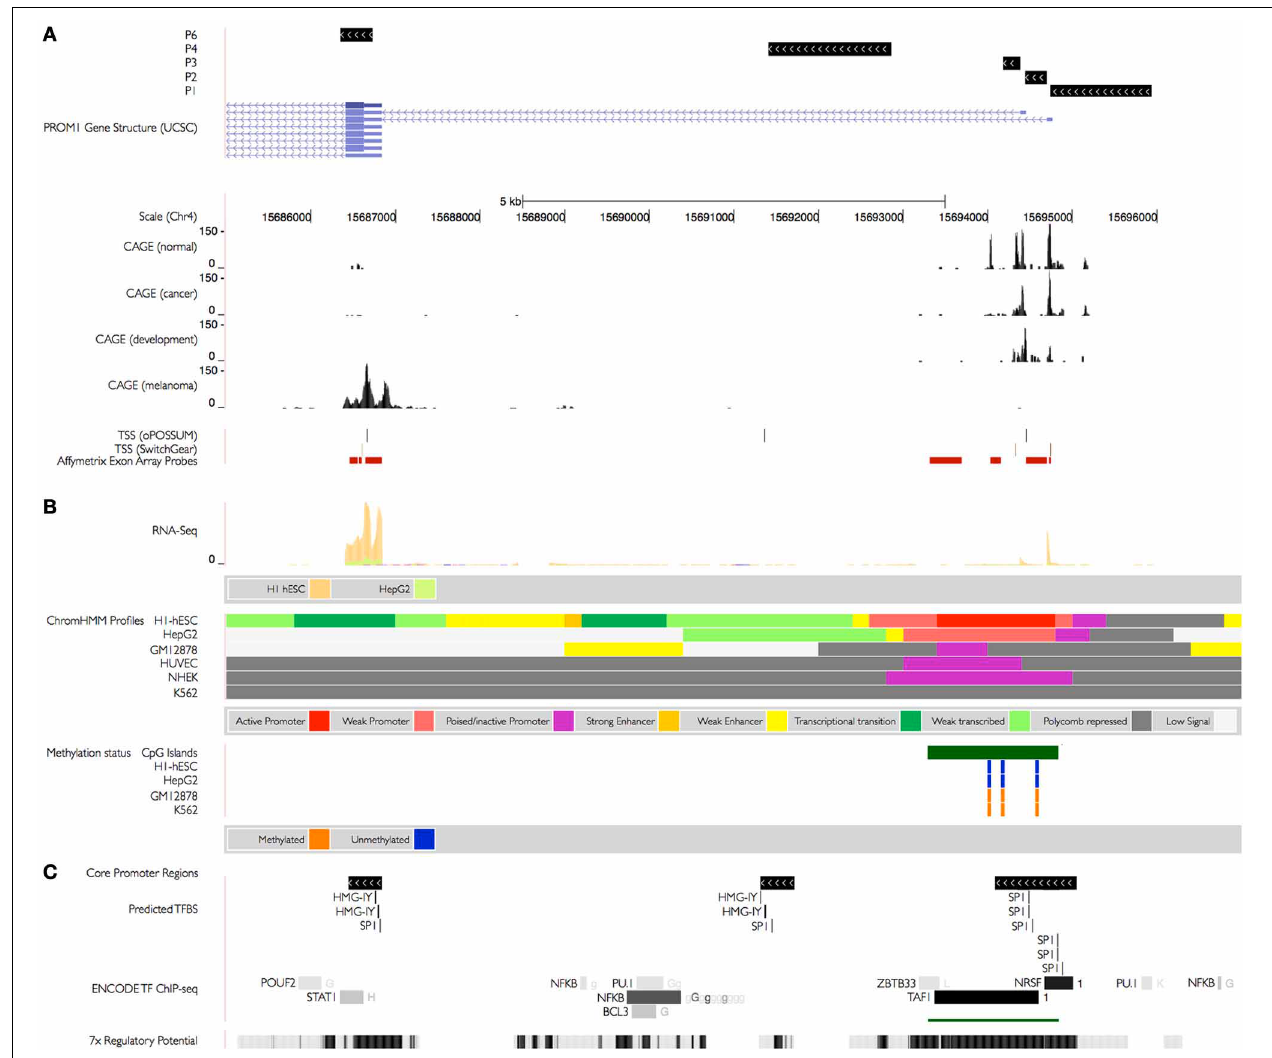
FIGURE 2 | PROM1 regulatory landscape. (A) Previously described PROM1 TSS (Promoter 1–3, 4) supported by Capped Analysis of Gene Expression (CAGE) assays from the FANTOM3 collection 57 containing 72 experimental samples of which 13 from normal tissues, 25 from different cancers, and 34 are from developmental states ( Table S3 ). Non-pathogenic tissue CAGE tags are distributed evenly whereas those obtained from tumors are biased toward promoter1and2;transcriptioninembryonictissuesisbiasedtowardpromoter 2. Promoter 6 is supported by CAGE tags obtained from melanoma cell lines and normal colon, small intestine, and rectum. TSS for promoters 1–4 and promoter 6 are supported by predictive models from the SwitchGear and the